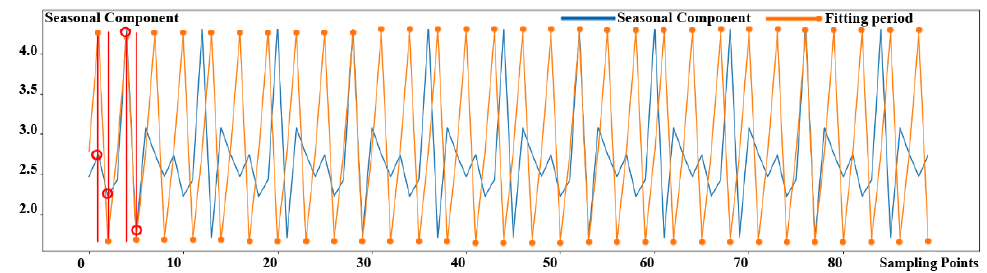
Figure 4. Period fitting of seasonal component